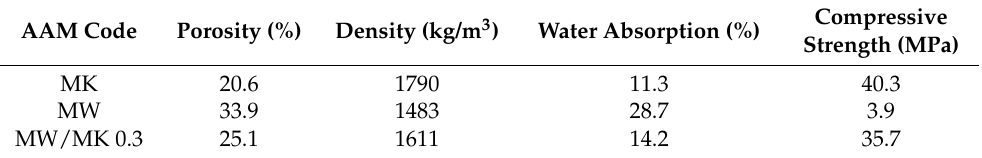
Table 4. Physical properties of selected AAMs produced with the use of H 2 O/Na 2 O ratio in the activating solution 16, after curing at 40 ◦ C for 24